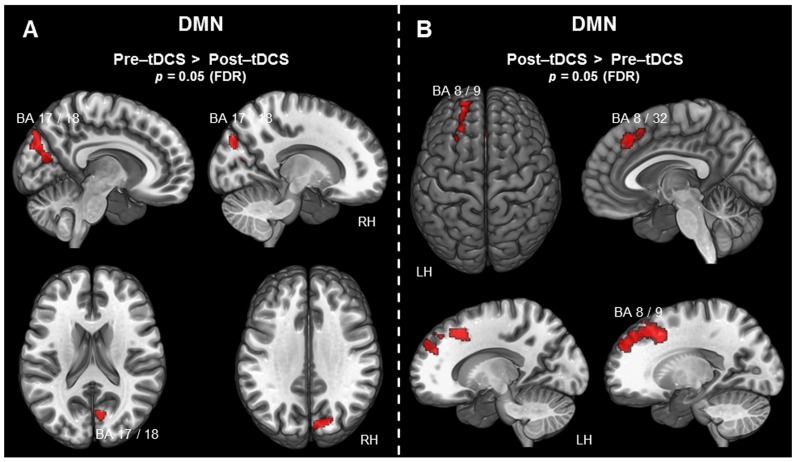
Voxel-wise difference maps for the DMN.Activity detected in the context of the DMN is displayed at a cluster-level threshold of p<0.05 (FDR corrected) and projected on the MNI template brain (ICBM 152). A) Areas associated with the DMN exhibiting decreased activity following tDCS. B) Areas associated with the DMN exhibiting increased activity following tDCS. (BA =  Brodmann area; DMN =  default mode network; FDR =  false discovery rate; LH =  left hemisphere; RH =  right hemisphere).